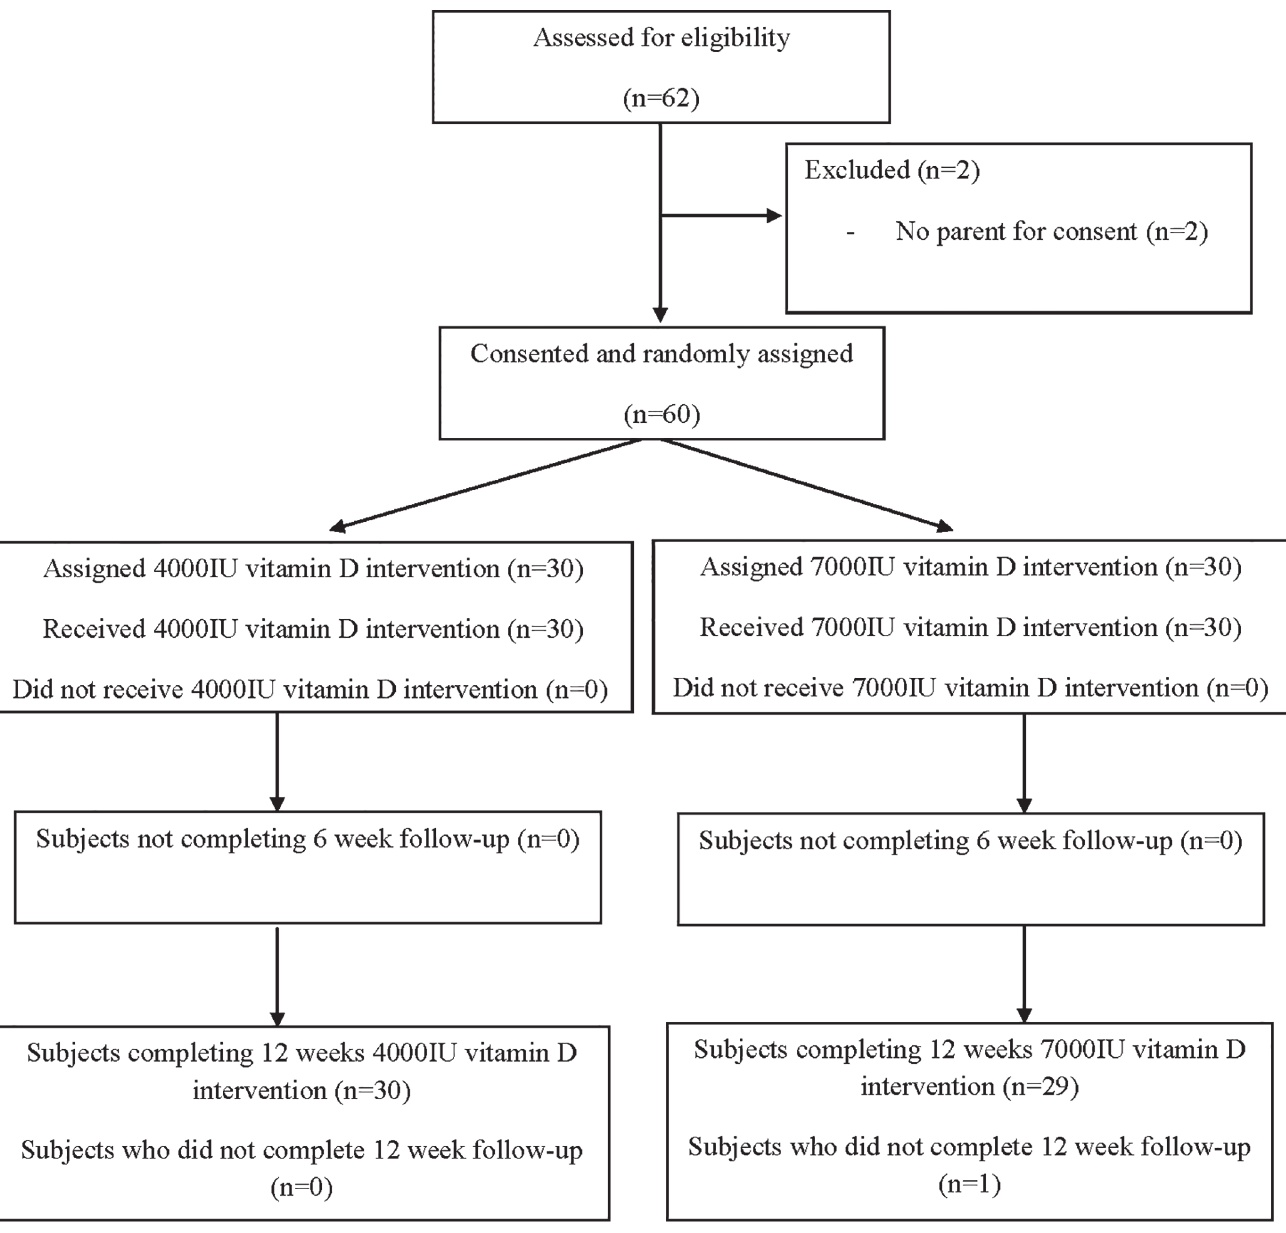
Fig 1. Consort flow diagram for subjects randomized, drop-outs, and completing the trial of daily 4000IU or 7000IU vitamin D3 supplementation in HIV-infected children and young adults.